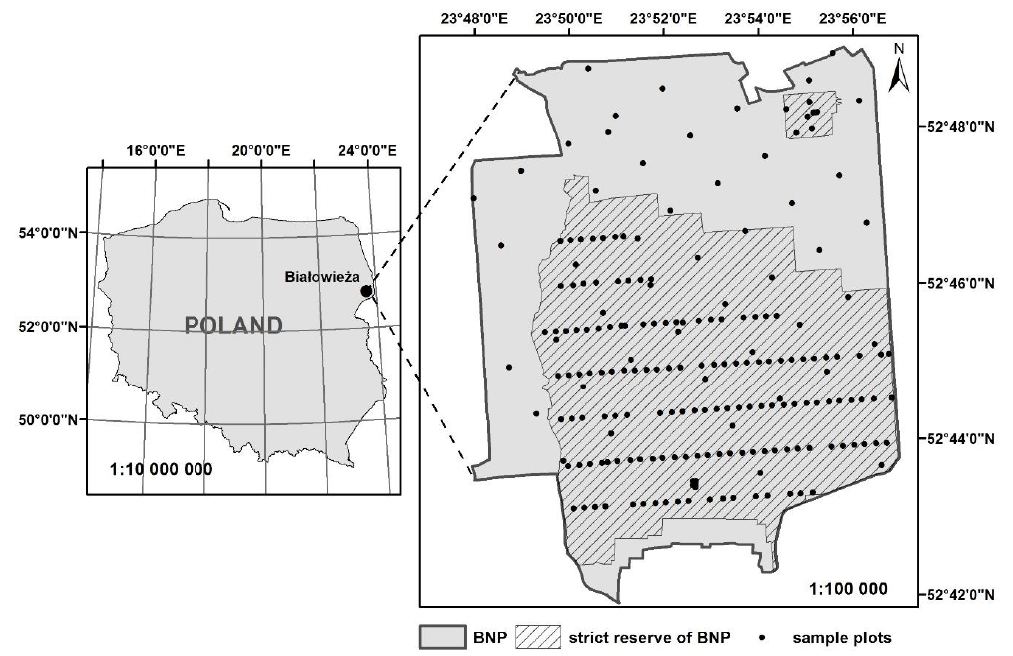
Figure 1. Location of Białowieża National Park (BNP) and sample plots.